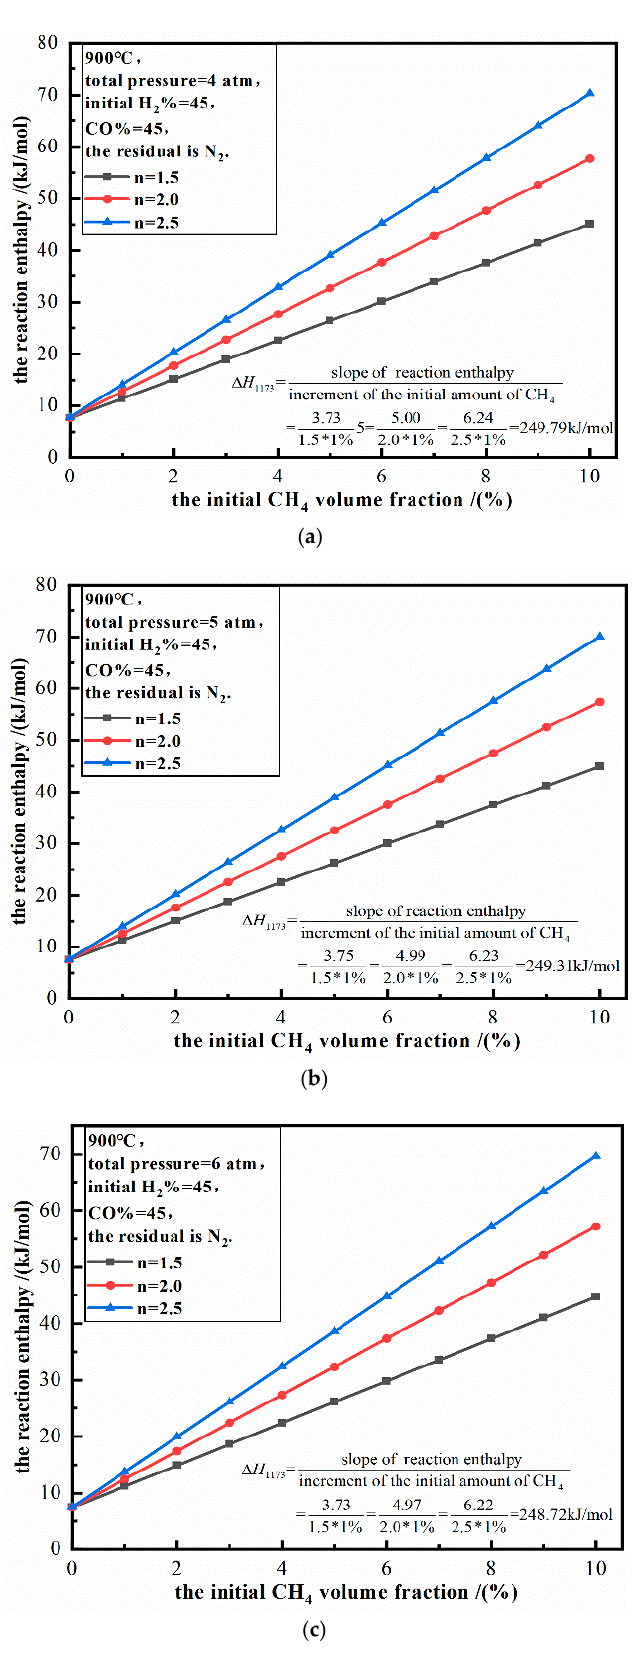
Figure 9. The relationship between the reaction enthalpy and the initial CH 4 volume fraction at 900 °C with H 2 % = 45, CO% = 45. ( a ) the total pressure is 4 atm; ( b ) total pressure is 5 atm; ( c ) total pressure is 6 atm.